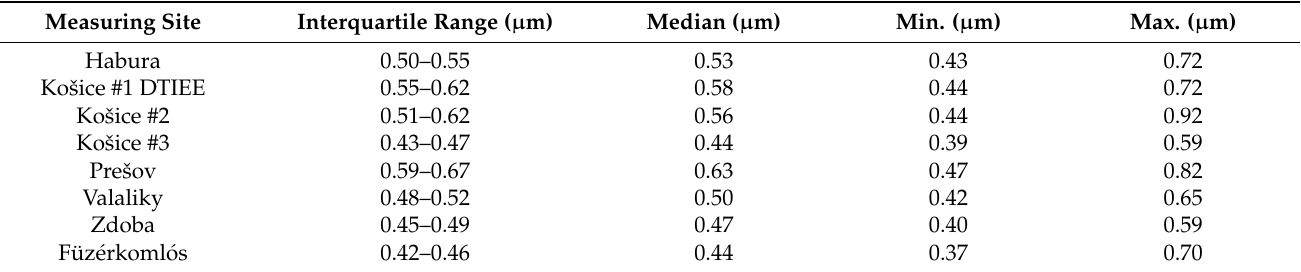
Table 3. Typical particle size by measuring site: interquartile range, median, minimum, and maxi- mum.